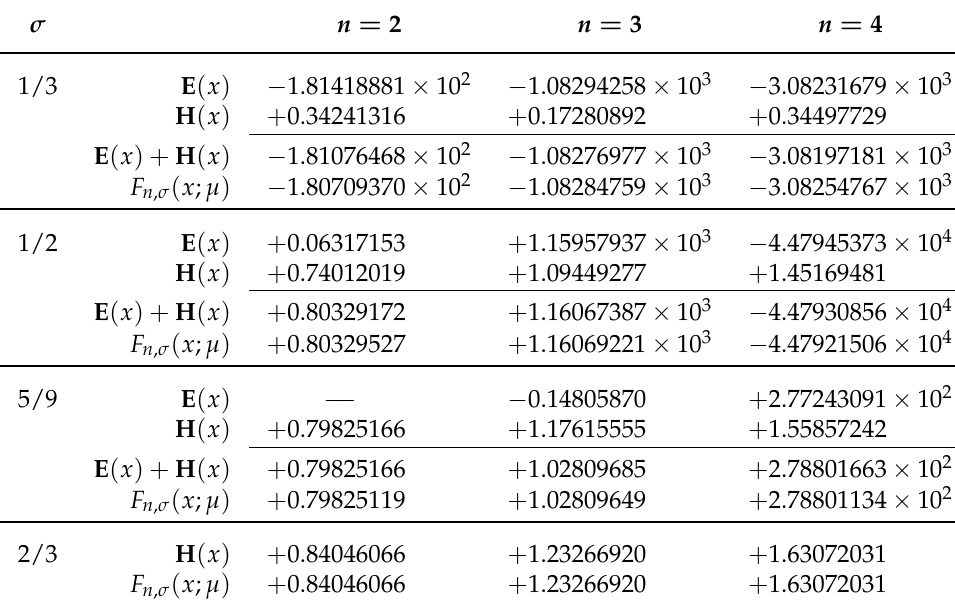
Table 1. The values of the exponential and algebraic expansions compared with F n , σ ( x ; µ ) for large x > 0 for different values of σ and n when µ = 3/4 and x =